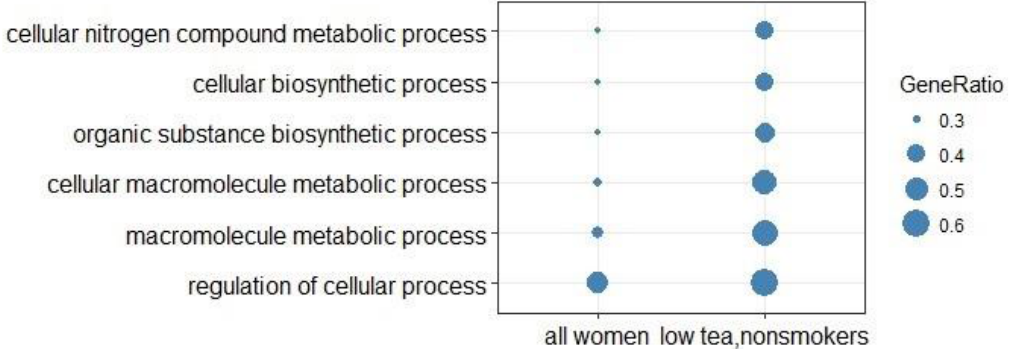
Figure 4. Group comparison of Gene Ontology biological process categories using a gene list of the top 100 significantly differentially expressed genes between high and low consumers in the “all women” group versus the “low tea, nonsmoking” group. GeneRatio indicates “number of genes in common between gene list and GO-category/number of genes in gene list.”